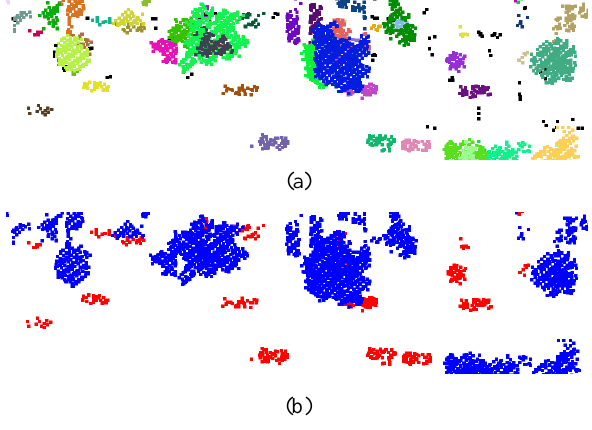
Figure 5. The classification result of rough surfaces, (a) is the rough surfaces, and (b) is the classification result. The points colored by blue are vegetation, and the points colored by red are vehicles.